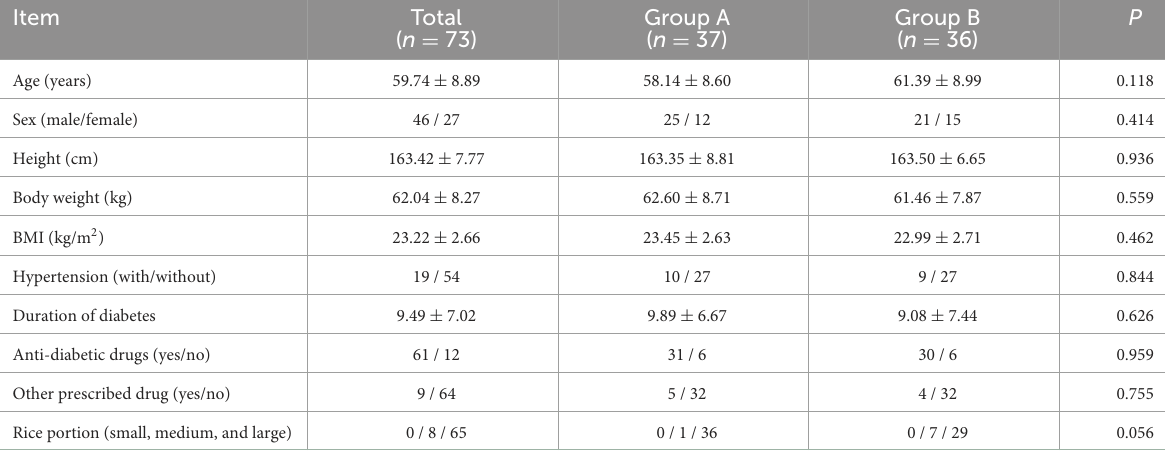
TABLE 2 General condition of the subjects ( n =